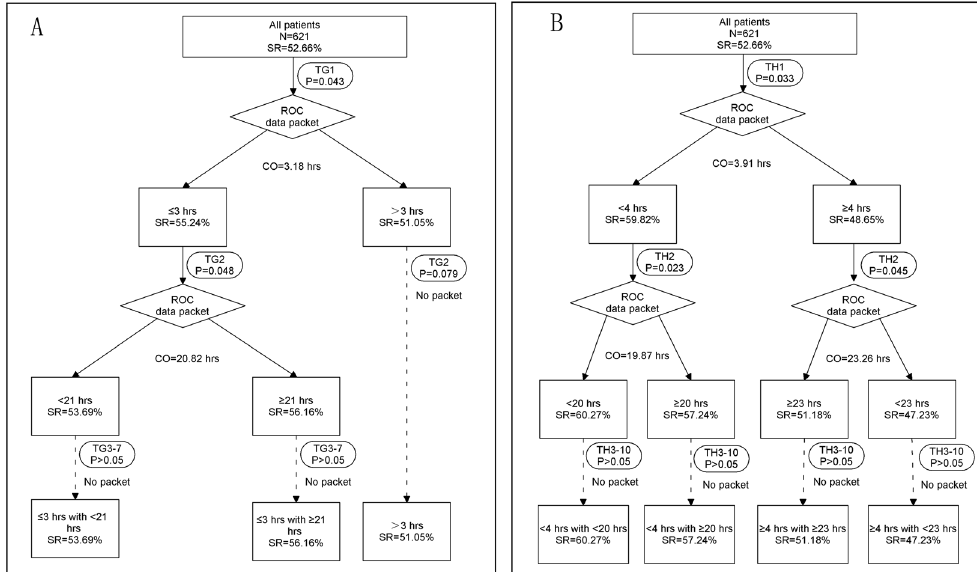
Figure 1. Steps of data packet after ROC curve analysis. TG: Time of glucocorticoid; TH: Time of haemoperfusion; CO: Cut-off time; SR: Survival rate; ROC: Receiver operating